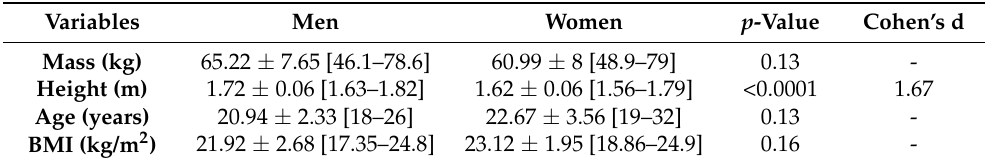
Table 1. Characterization of the sample regarding age, mass, height and BMI. Mean ± standard deviation